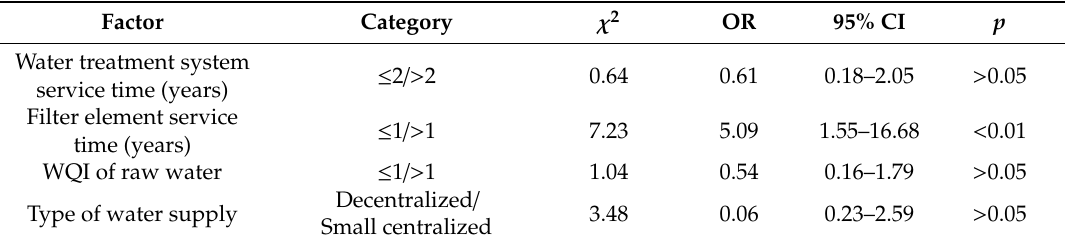
Table 3. Binary logistic regression analysis of factors influencing the WQI of purified